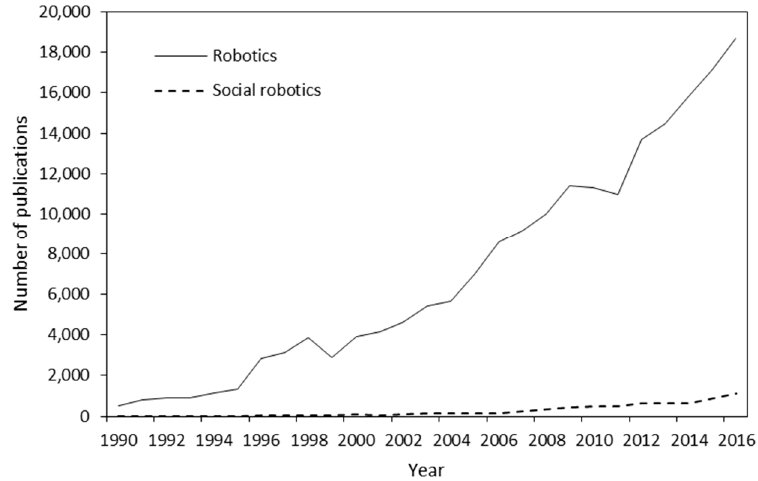
Figure 2. Yearly trends of publications on robotics and social robotics.